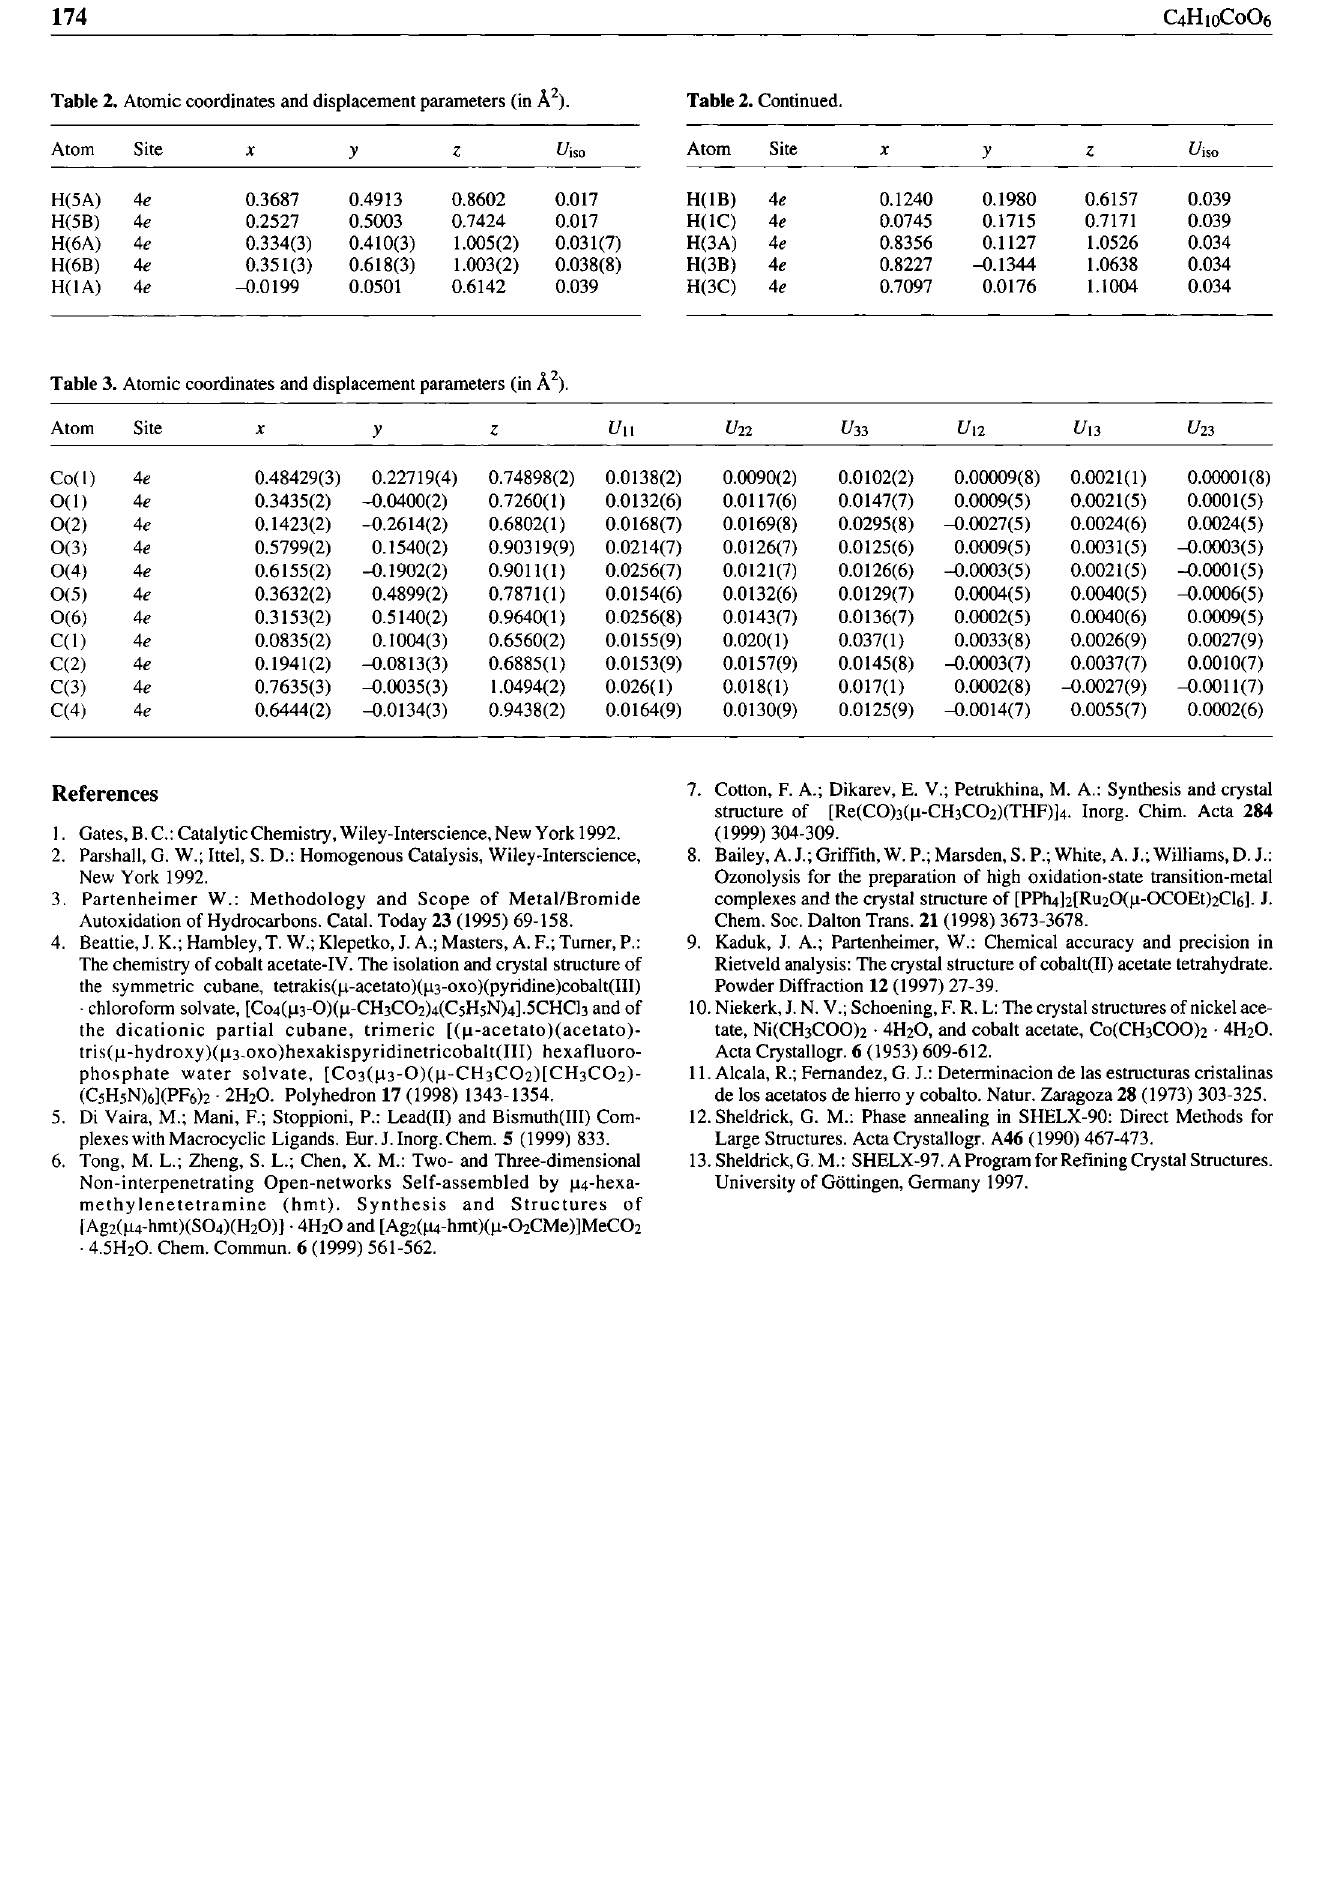
Table 2. Atomic coordinates and displacement parameters (in Ä 2 ).